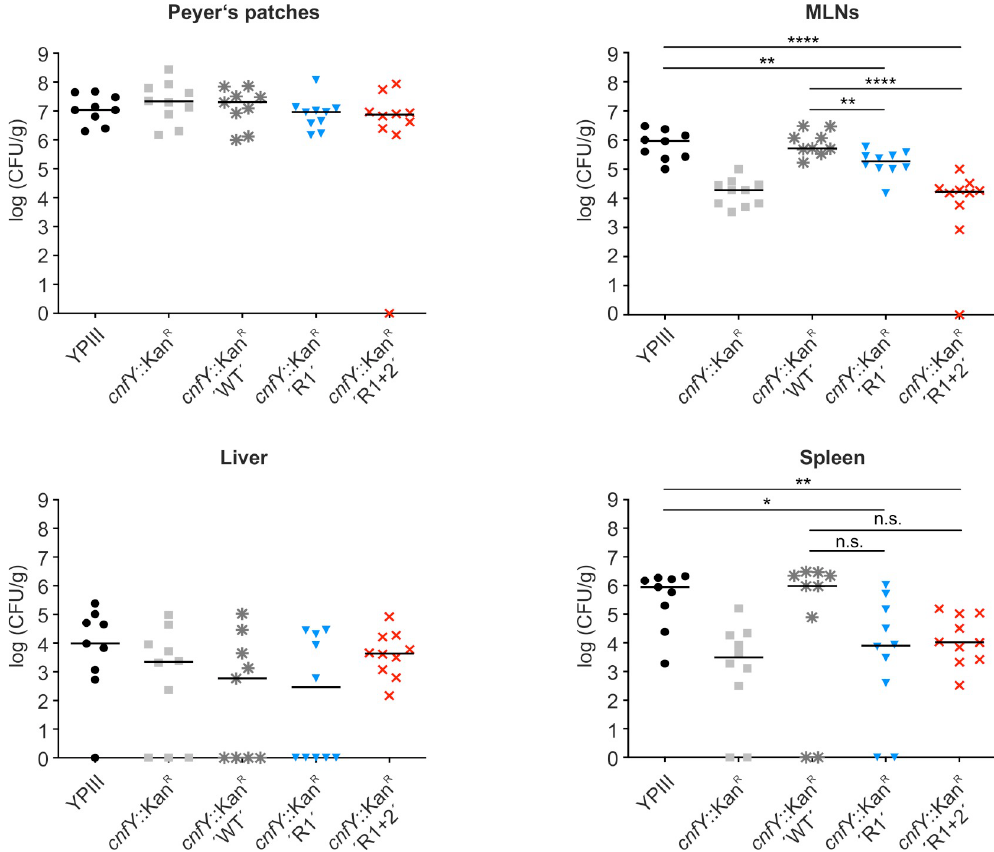
Fig 9. Stabilizing point mutations in the cnfY RNAT affects tissue colonization by Y . pseudotuberculosis . (A) BALB/c mice (n = 10/strain) were orally infected via food pellets with 2x10 8 CFU of either Y . pseudotuberculosis YPIII harboring the empty vector pJNS11 (black line + black dots) or the cnfY deficient mutant YP147 ( cnfY :: Kan R ) harboring the empty vector pJNS11 (grey line + grey squares) or the cnfY complementation vector pJNS10 (pP : cnfY + ) including the wild type (grey cnfY line + grey asterisk), the R1 (blue line + blue triangles; pBO6503)), or the R1+2 (red line + red crosses; pBO6504) variant of the cnfY RNAT. 5 days post infection, mice were sacrificed and the number of bacteria in homogenized organs (Peyer‘s patches, mesenteric lymph nodes (MLNs), Liver, and Spleen) was determined by plating. The scatter plots represent data of two independent experiments (5 mice/group). Numbers of CFU per gram were determined by counting viable bacteria on plates. The statistical significances between the wild type and the YP147 mutant were determined by the Mann-Whitney U test. P-values: � : < 0.05; �� : < 0.01, ���� : < 0.0001. Displayed data represent results from two individual experiments (biological